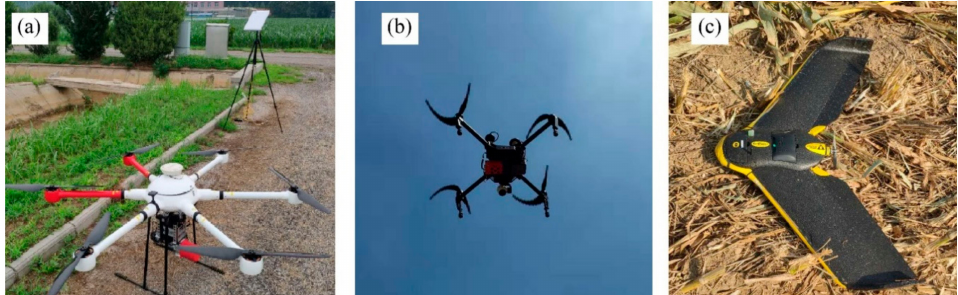
Figure 3. Three unmanned aerial vehicles (UAV) platforms used in this study: ( a ) the EWZ-D6 Pro six-rotor UAV, ( b ) the DJI M100, and ( c ) the eBee wing-fixed UAV.